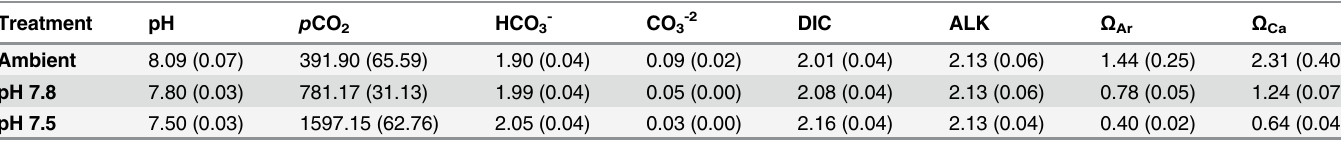
Table 1. Average carbonate chemistry with standard deviation in brackets from July 2011 to July 2015 for the long-term ocean acidification experi- ment with Tanner Crab ( Chionoecetes bairdi) . p CO 2, partial pressure of carbon dioxide in μ atm; HCO 3- , bicarbonate ion in μ mol kg -1 ; CO 3-2 .